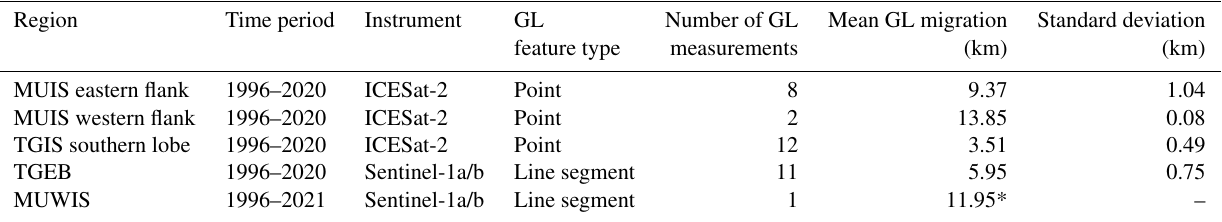
Table 1. The mean grounding line (GL) migration distance and standard deviation in five studied regions including the Moscow University Ice Shelf (MUIS) eastern flank, MUIS western flank, Totten Glacier Ice Shelf (TGIS) southern lobe, Totten Glacier East Branch (TGEB), and Moscow University Western Ice Shelf (MUWIS).